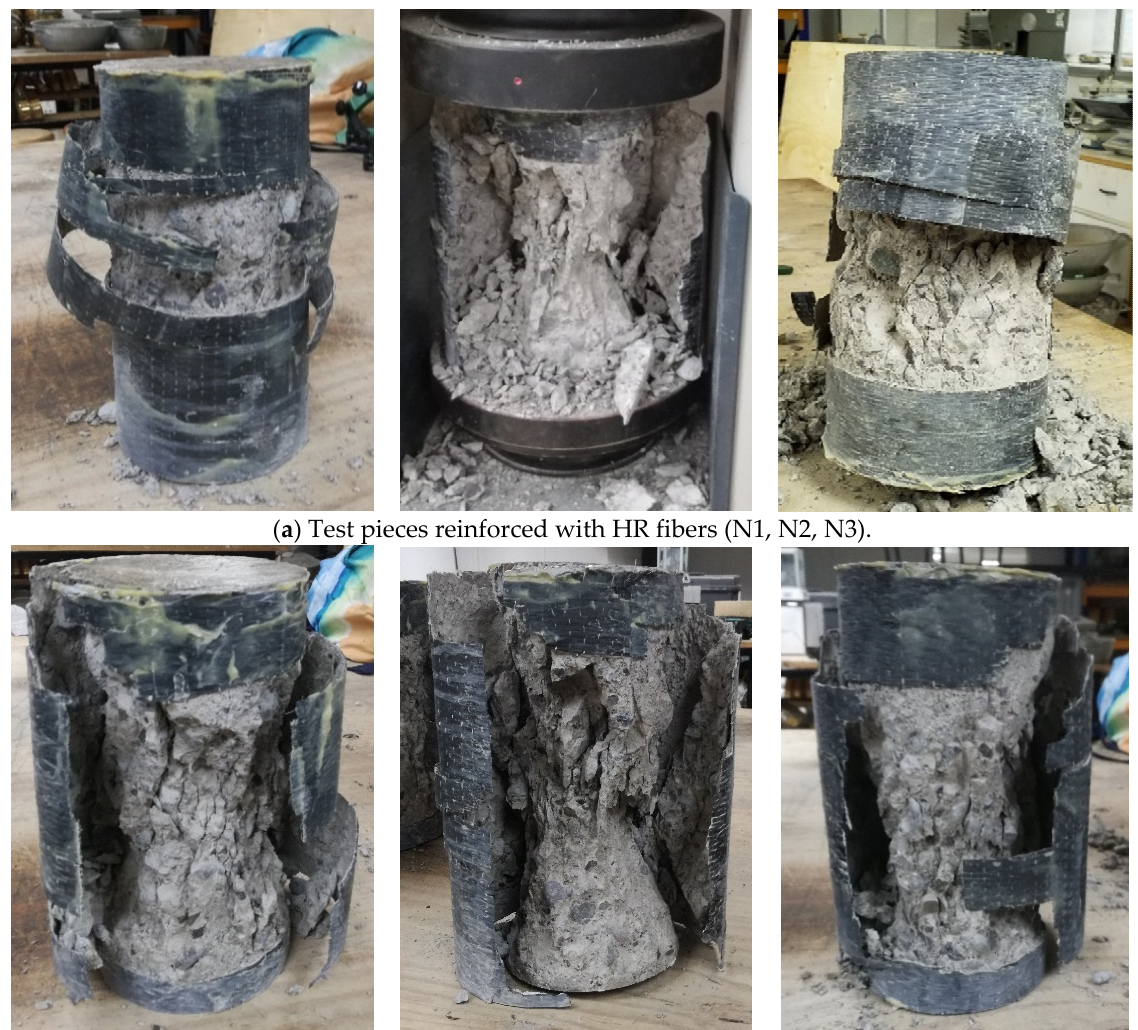
Figure 3. Images of fracturing in the compression-tested pieces. Table 4. Results of compression testing: average values, typical deviation, and strength increase. Test Piece